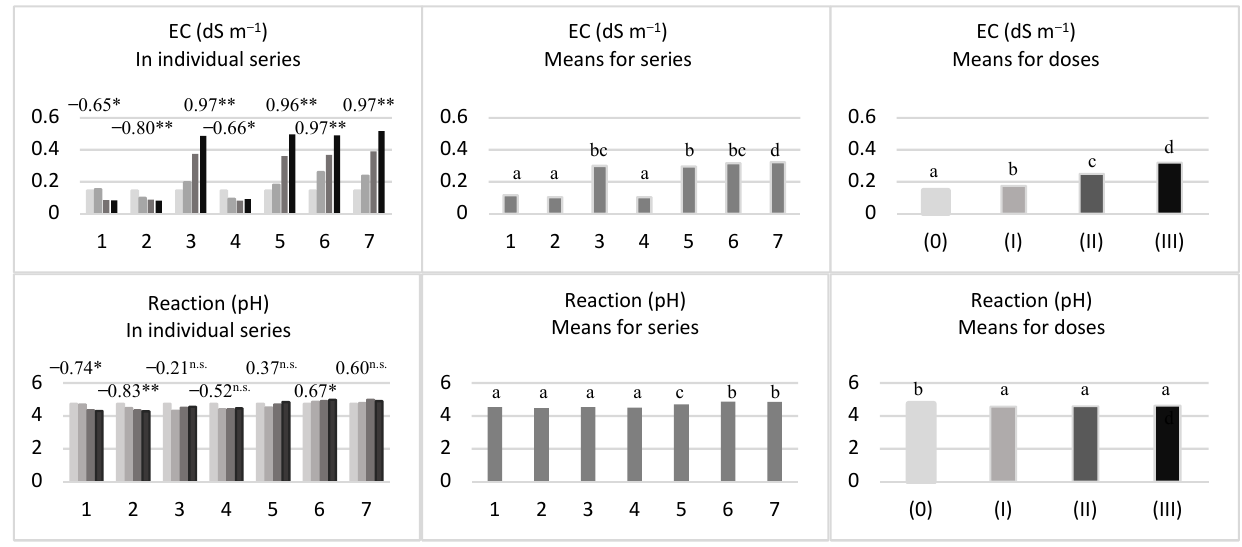
Figure 2. Values of electrolytic conductivity (EC) and reaction (pH) of soils. control (0); first metal dose (I); second metal dose (II); third metal dose (III); Series of experiment: 1—Cd, 2—Pb, 3—Zn, 4—Cd + Pb, 5—Cd + Zn, 6—Pb + Zn, 7—Cd + Pb + Zn; correlation coefficient ( r ) *—significant for p = 0.05; **—highly significant for p = 0.01; n.s. —not significant; n = 12; the letters from " a " to " d " differentiate homogeneous groups, means followed by the same letter do not differ at p = 0.05 by the LSD test.